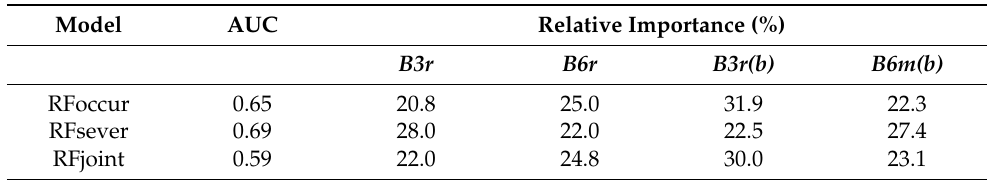
Table 4. Area under the curve (AUC) of random forest (RF) models and the relative importance of predictors for (1) the disturbance occurrence model (NDG vs. DG0-1; RFoccur), (2) the disturbance severity model (DG0 vs. DG1; RFsever), and (3) the combined occurrence and severity model (NDG vs. DG0 vs. DG1; RFjoint). Models were built using the four best-ranked S2 predictors, pre-selected through their performance metrics in the logistic